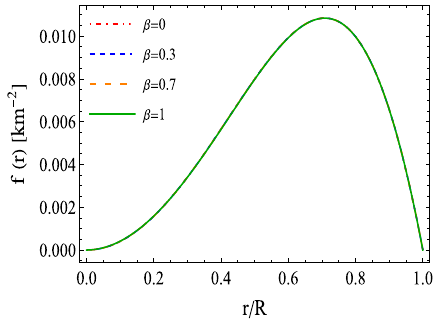
Fig. 2 The behavior of the deformation function versus radial coordi- nate r / R for the solution 4.1 corresponding to the case ˆ (cid:14) =